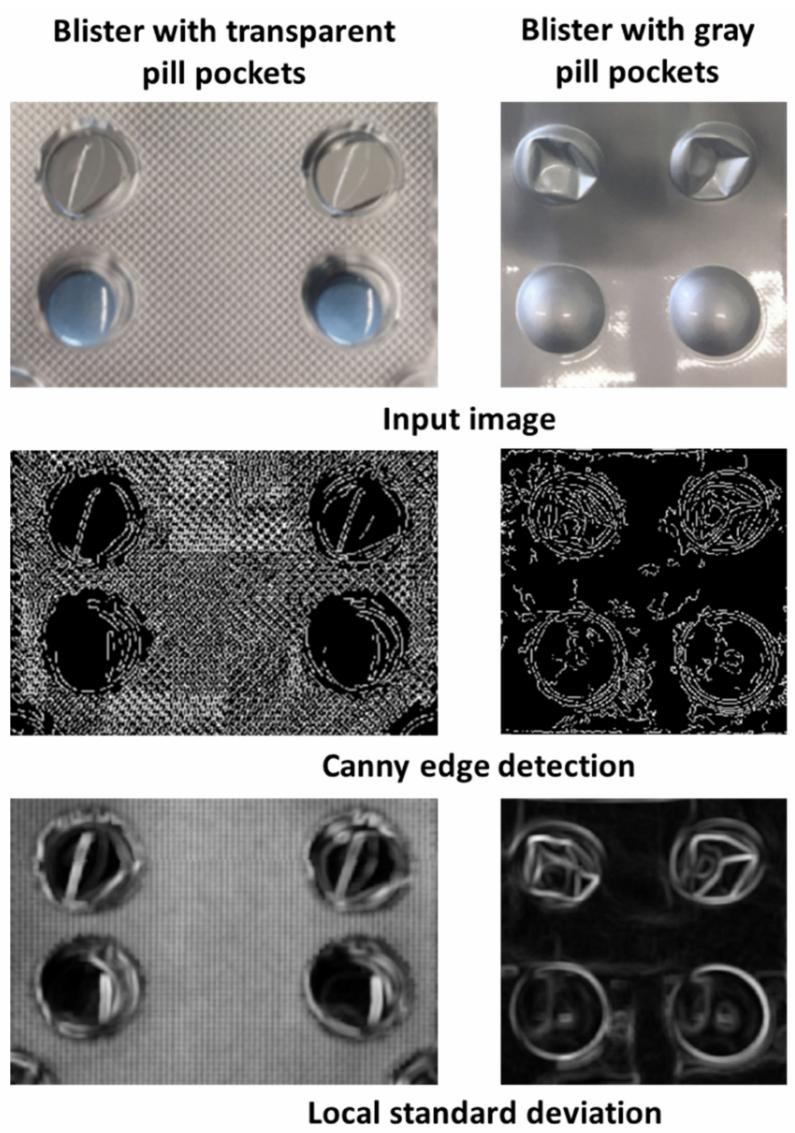
Figure 6. Comparison of transparent and gray pill